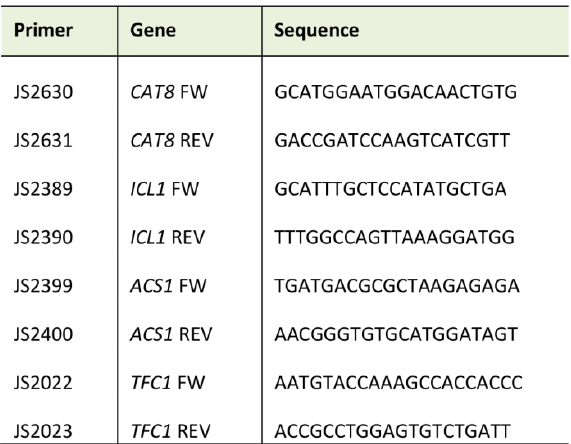
Table 2. RT-PCR primer